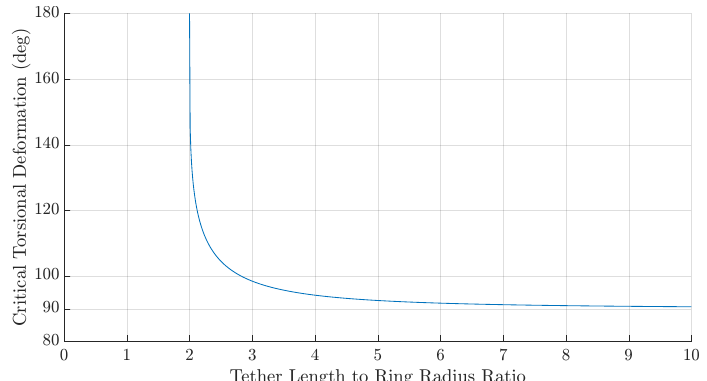
Figure 20. Critical torsional deformation for different tether-length-to-ring-radius